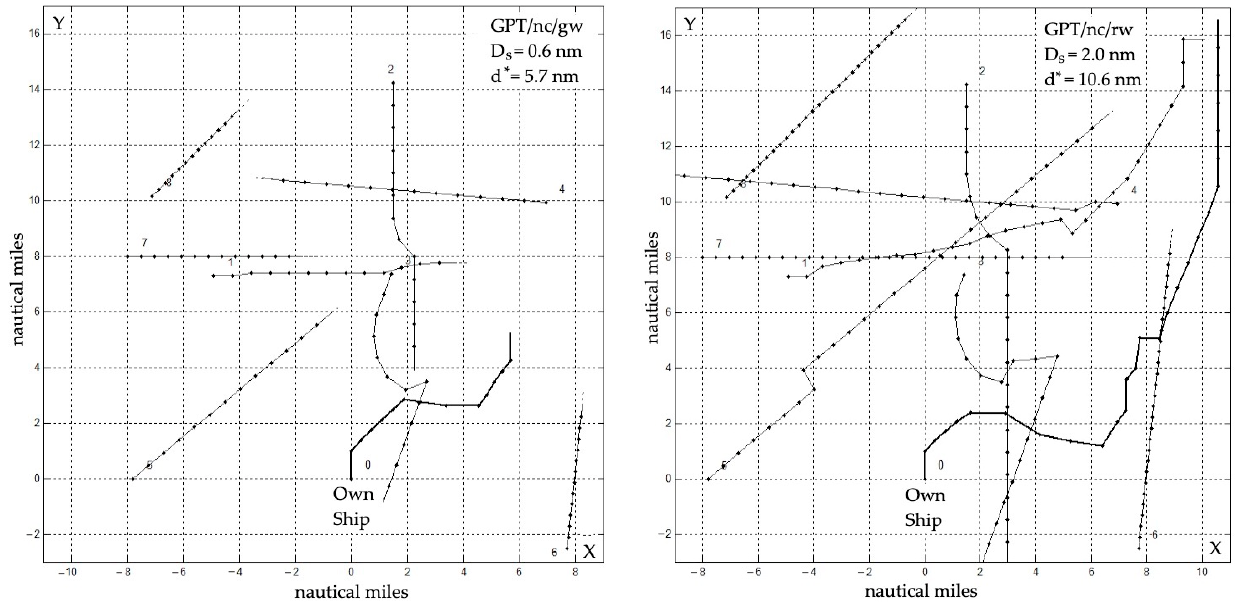
Figure 14. Safe game positional trajectory of one’s own ship determined by the GPT algorithm, in good (gw) and restricted (rw) visibility at sea, with cooperation of vessels (c) and non-cooperation between vessels (nc); d* means the final deviation of the ship’s own course from the initial value after exiting the collision situation.